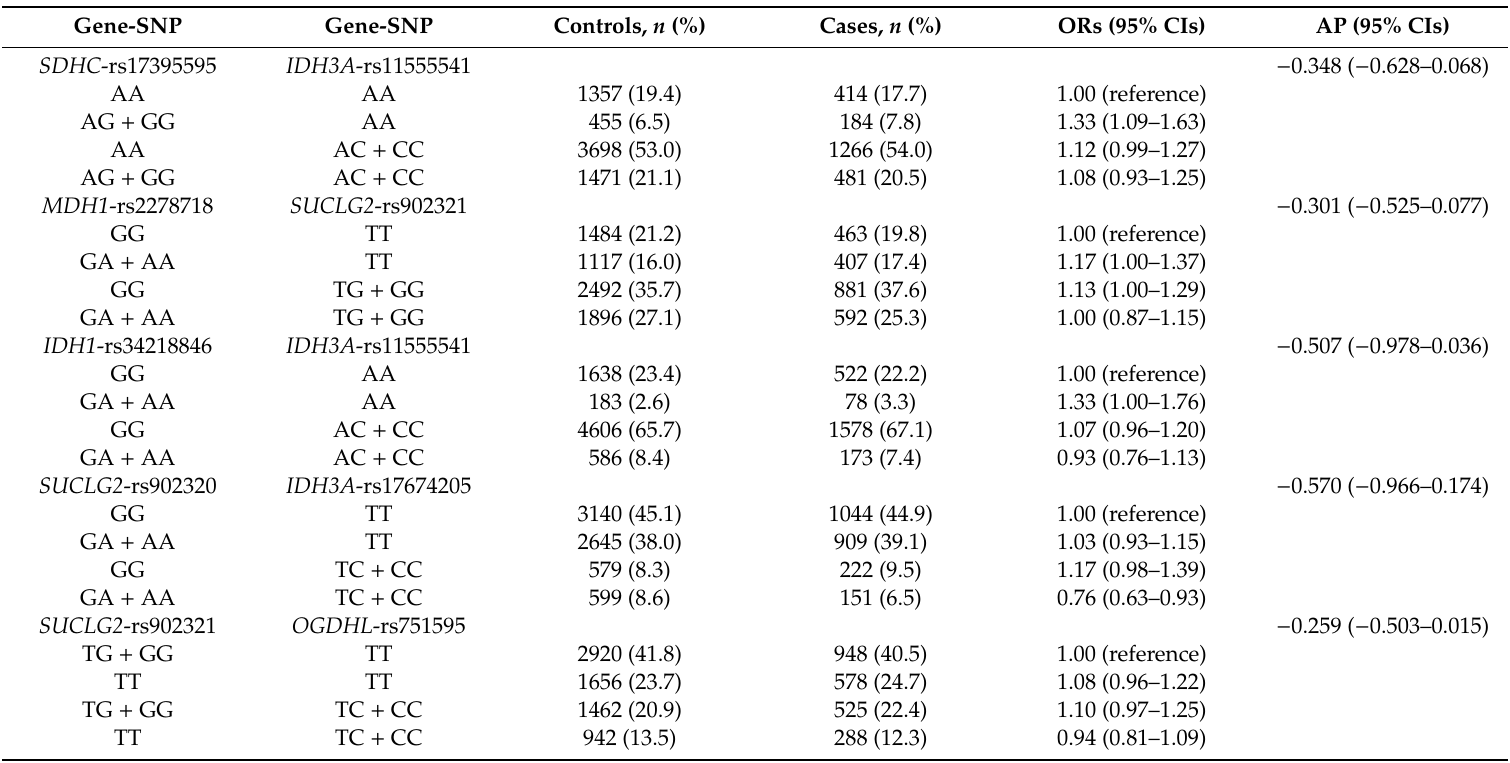
Table 6. Odds ratios (OR) and 95% confidence intervals (CIs) for the combined e ff ect of the citric acid cycle SNPs on the risk of colon cancer, showing the 95% CIs of AP not containing